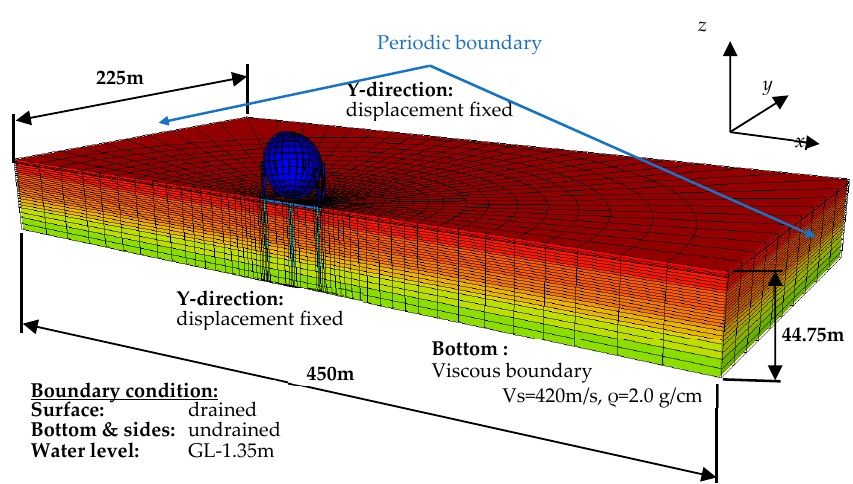
Figure 1. Soil boring log and 1D FE mesh with boundary conditions: ( a ) soil log; ( b ) shear wave velocity comparison; ( c ) FE mesh and BCs.